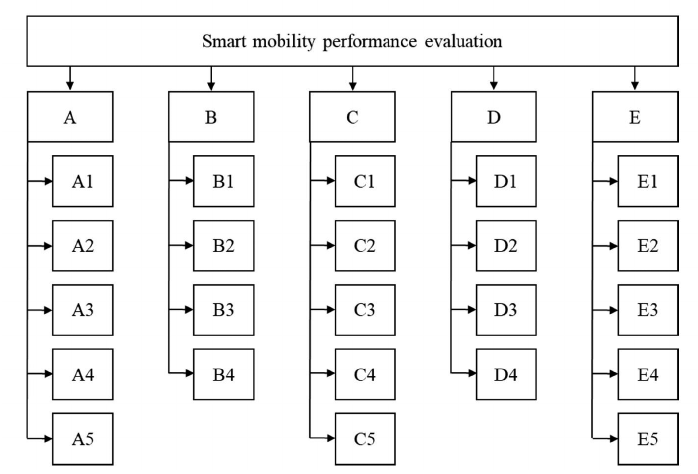
Figure 1. Hierarchical model for evaluation of smart